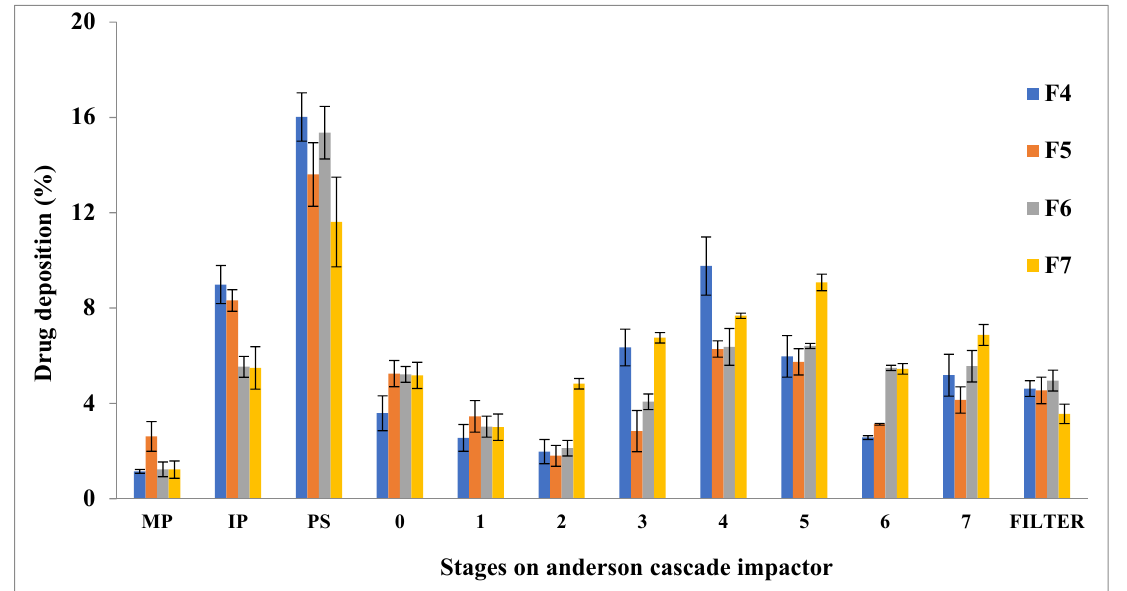
Figure 6. In vitro aerosol deposition pattern of microparticles at various stages of ACI.